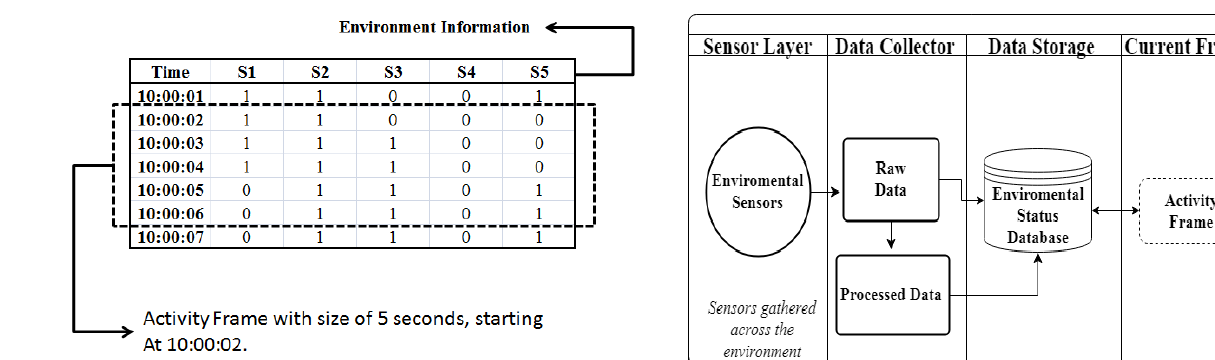
Figure 6: Data flow showing the activity frame